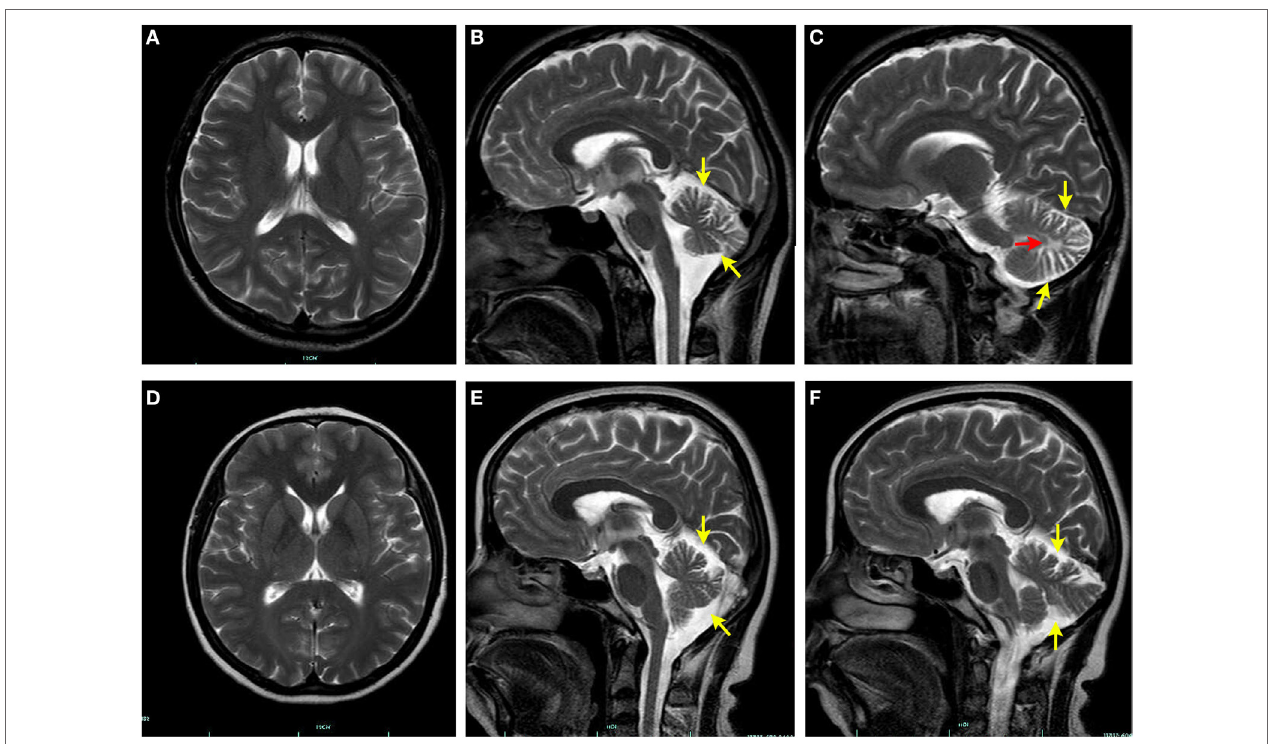
FIGURe 2 | Brain magnetic resonance imaging (MRI) findings. No signal changes are seen in the axial T2-weighed brain MRI of the proband (a) and his mother (D) . Sagittal T2-weighed brain MRI of the proband (B,C) and his mother (e,F) shows manifest cerebellar atrophy (yellow arrow). White matter hyperintensity (red arrow) is also evident in cerebellum of the proband (C)